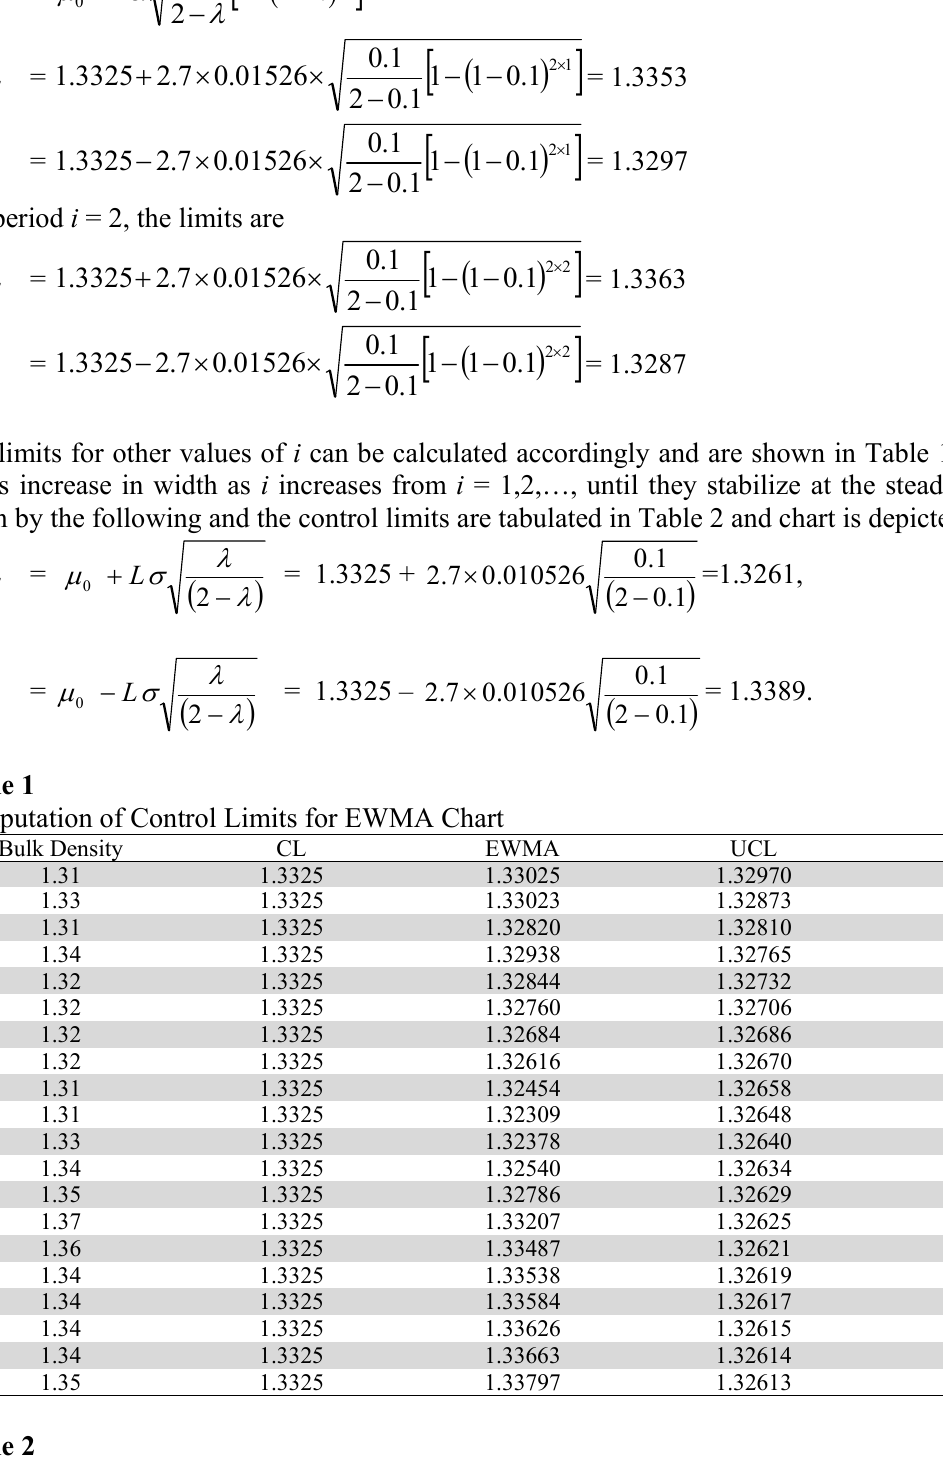
Control Limits for EWMA